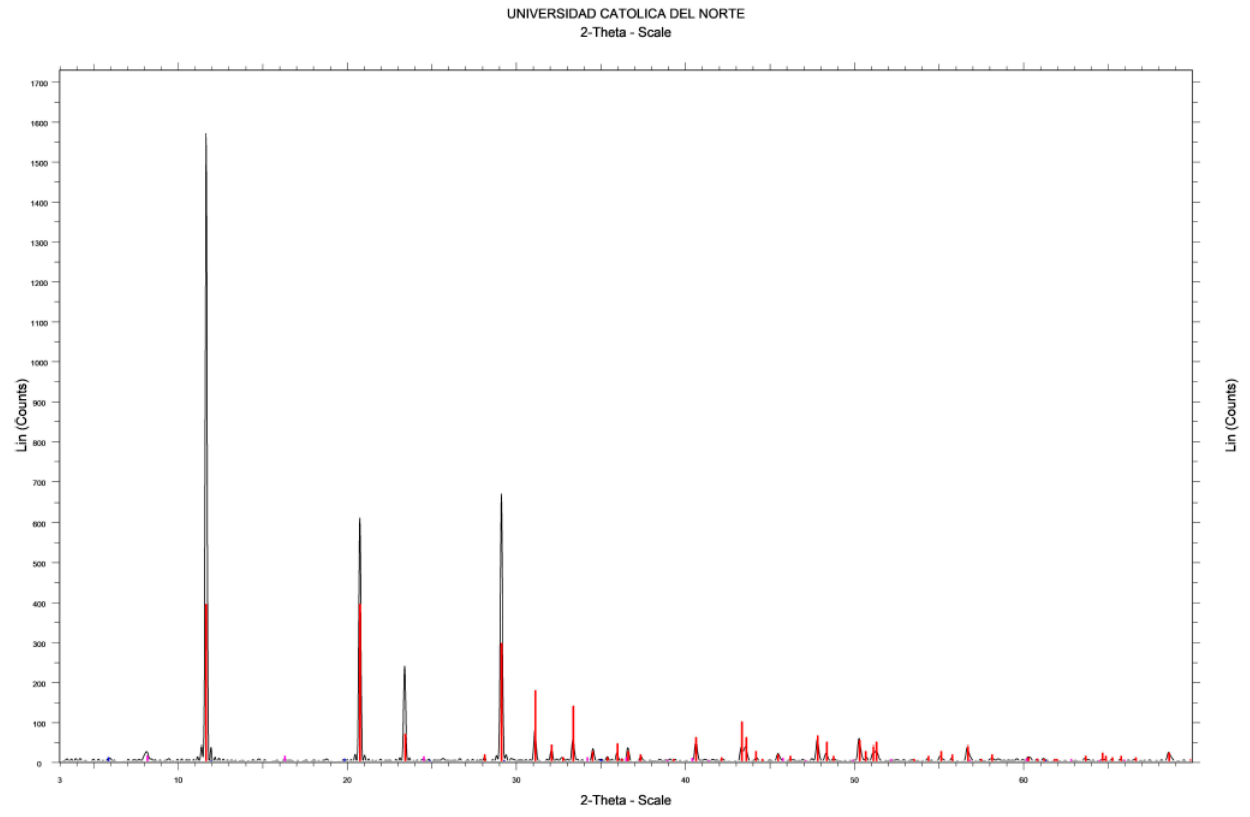
Figure 6. XRD patterns of the solids using CaO.